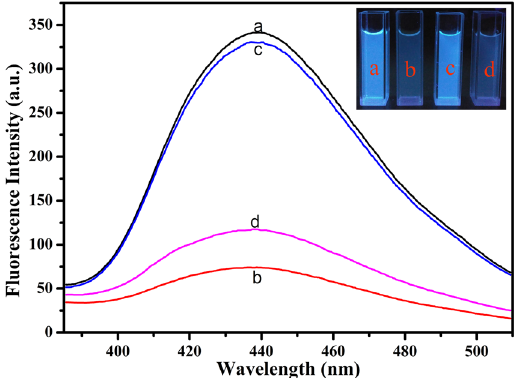
Figure 3. Fluorescence spectra and image of N-CDs in the presence of different composition ( a ) mere N-CDs; ( b ) in the presence of 5 μ M Cu 2 + ; ( c ) in the presence of 5 μ M Cu 2 + and 50 μ M PPi; ( d ) in the presence of 5 μ M Cu 2 + , 50 μ M PPi and 1 U/mL ALP.